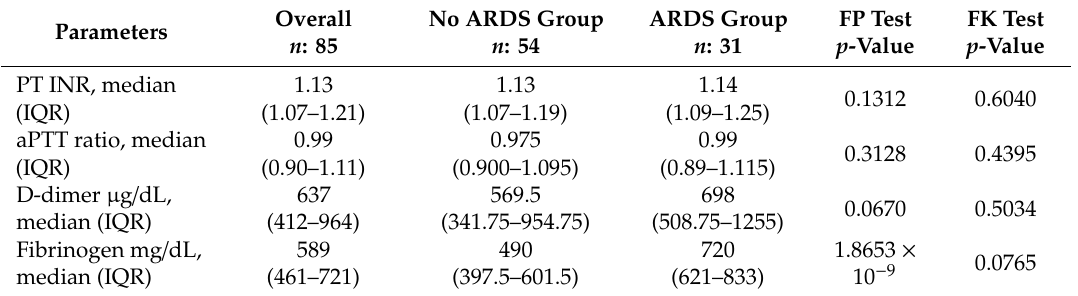
Table 4. Comparisons of laboratory parameters between COVID-19 patients without and with acute respiratory distress syndrome